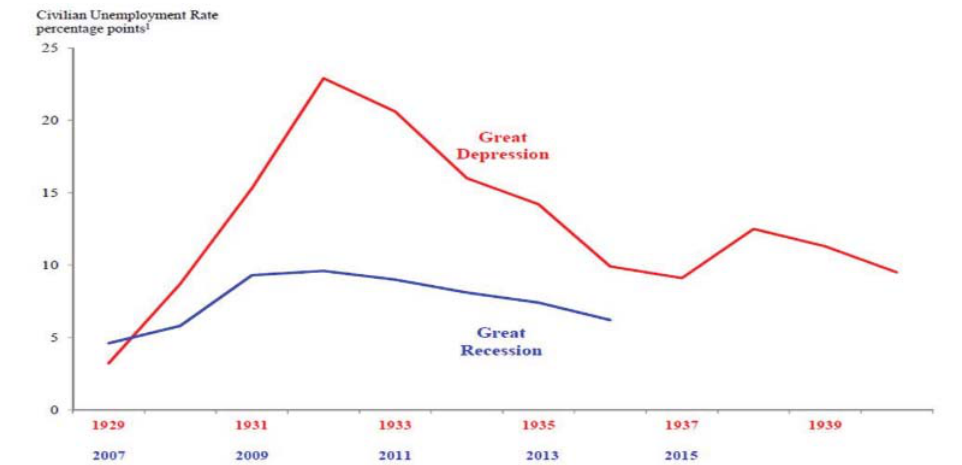
Fig. 4. Civilian unemployment rate for the United States Source: Anderson et al.